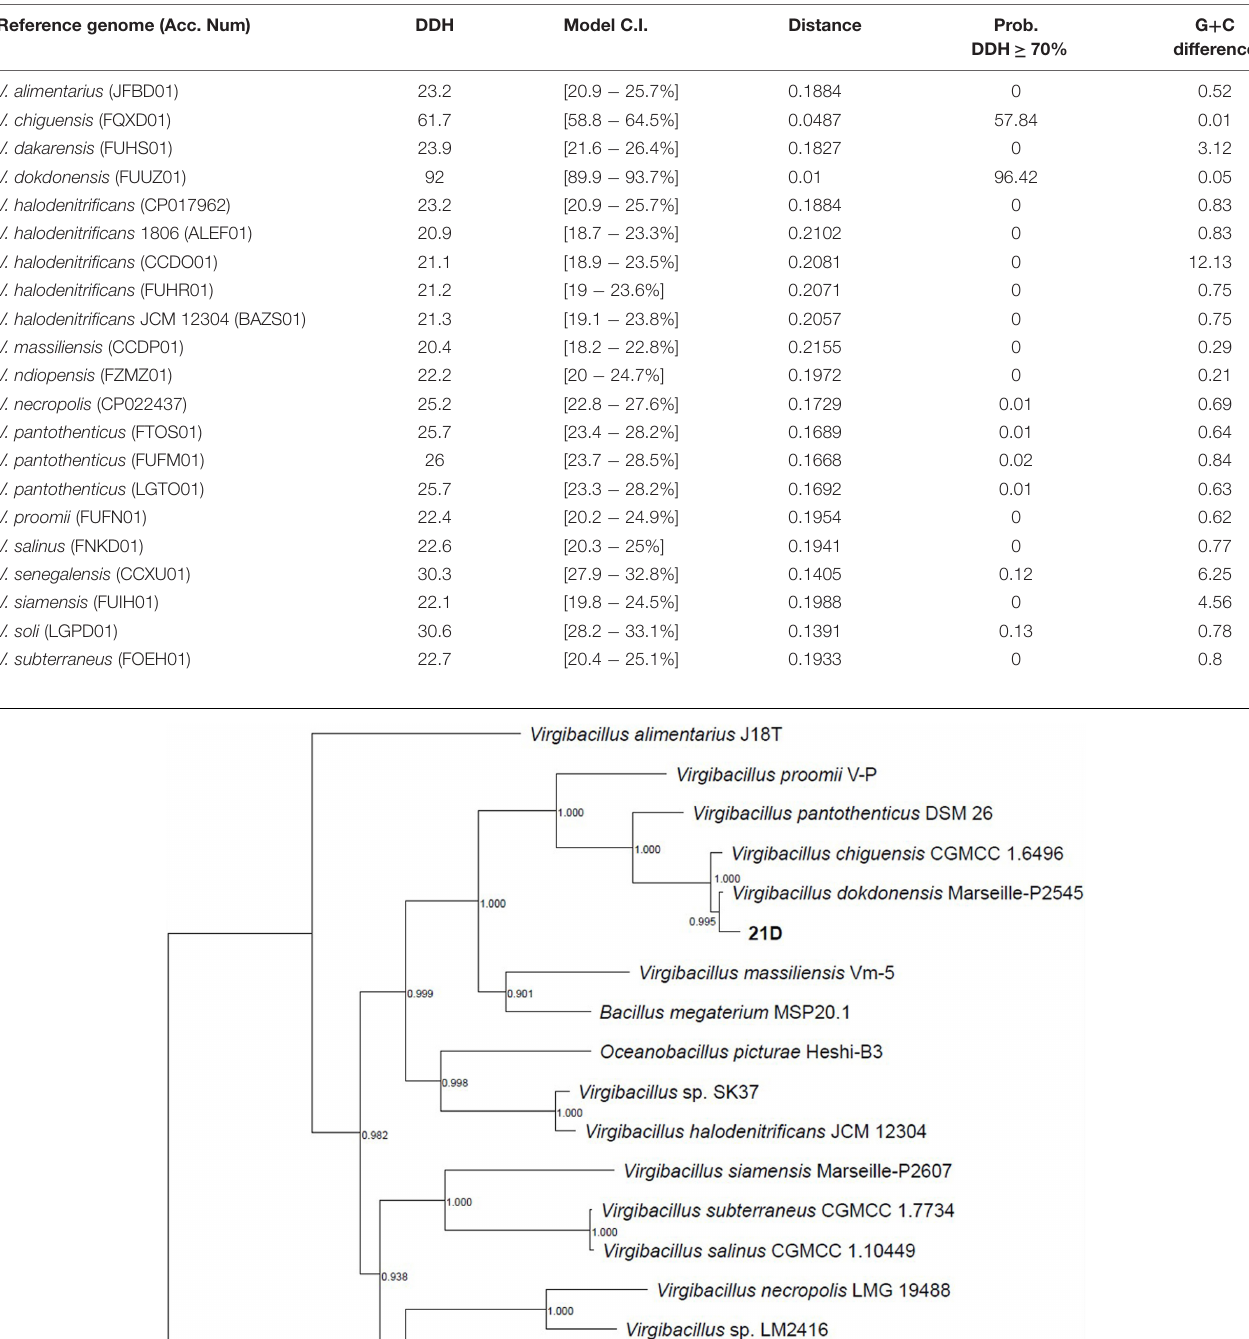
TABLE 6 | In silico DNA–DNA hybridization analysis by using Genome sequence-based (sub-)species delineation (GGDC) server (http://ggdc.dsmz.de/). Reference genome (Acc. Num)